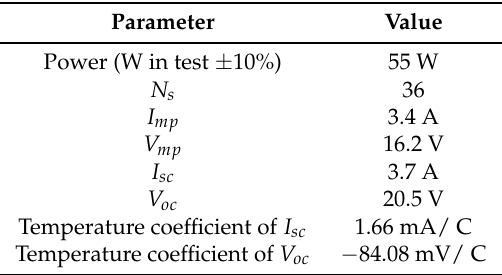
Table 3. Characteristics of Atersa A-55 PV panel.